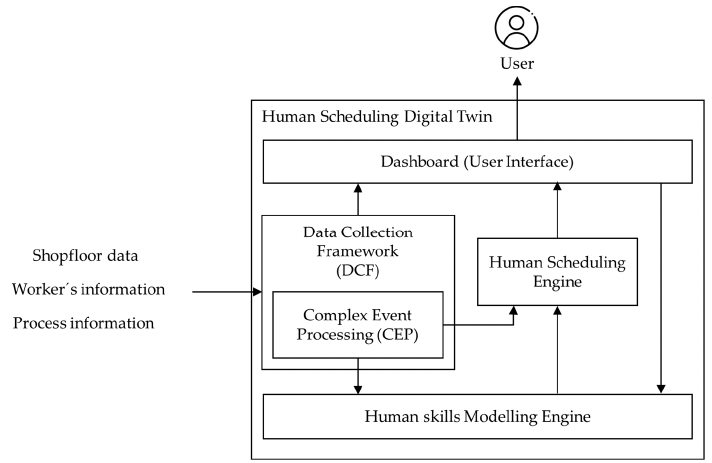
Figure 3. Human scheduling digital twin block diagram.